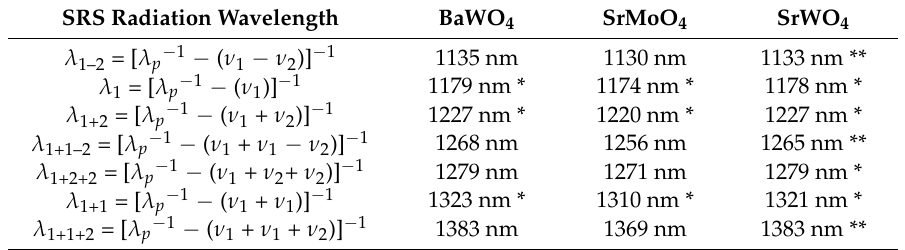
Table 3. SRS radiation wavelengths in BaWO 4 , SrWO 4 and SrMoO 4 crystals at 1063-nm pumping.